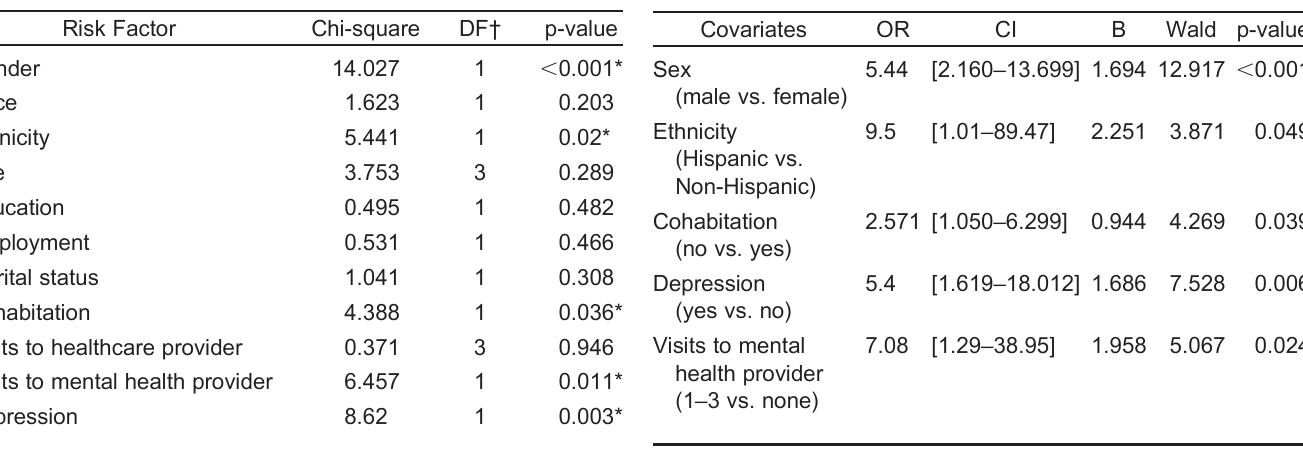
Table 2. Associations of demographic characteristics and risk factors with positive elder mistreatment screens.